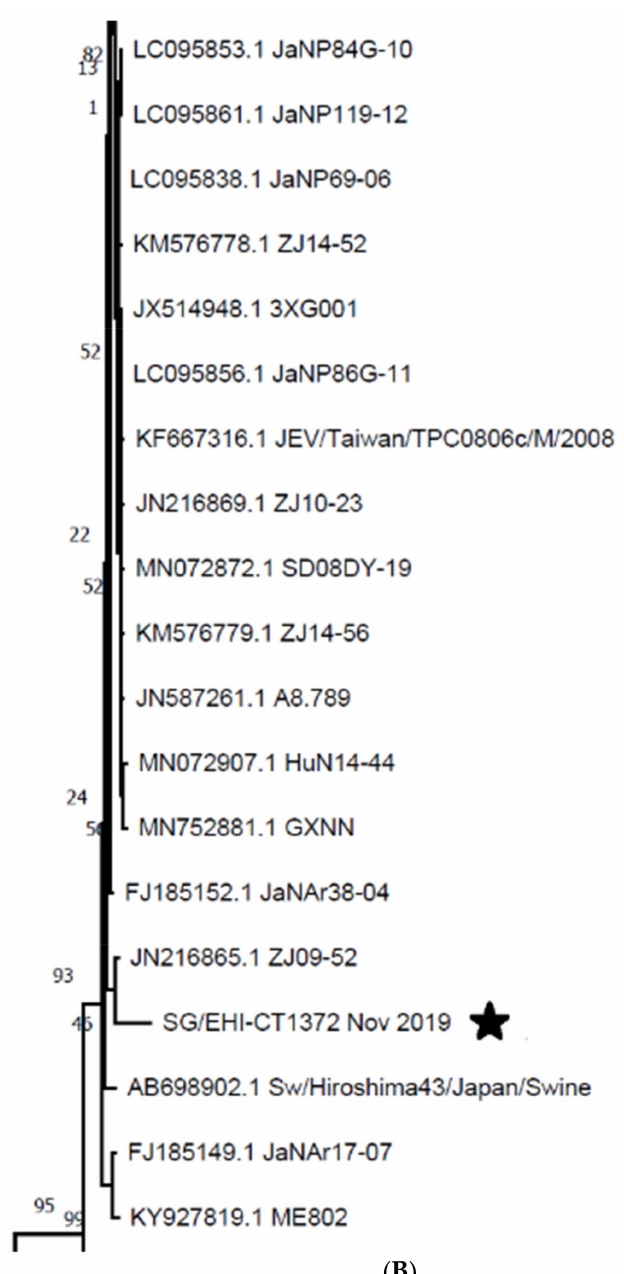
Figure 2. Maximum likelihood phylogenetic analysis of 129 truncated (701 bp) JEV E -gene sequences. This tree was constructed using TN93+G with 1000 bootstrap iterations; the outgroup is MVEV (NCBI Reference Sequence no. NC_000943.1). Only parts of the tree are presented for easier viewing (see Figure S1 for the full tree): ( A ) Sub-genotype I-a; ( B ) Partial sub-genotype I-b. The JEV E -gene sequences presented in this study are indicated with cluster A (blue) and cluster B (orange), as well as a star for SG/EHI-CT1372. Each node is labelled with the GenBank Accession No. (where available) followed by the sequence